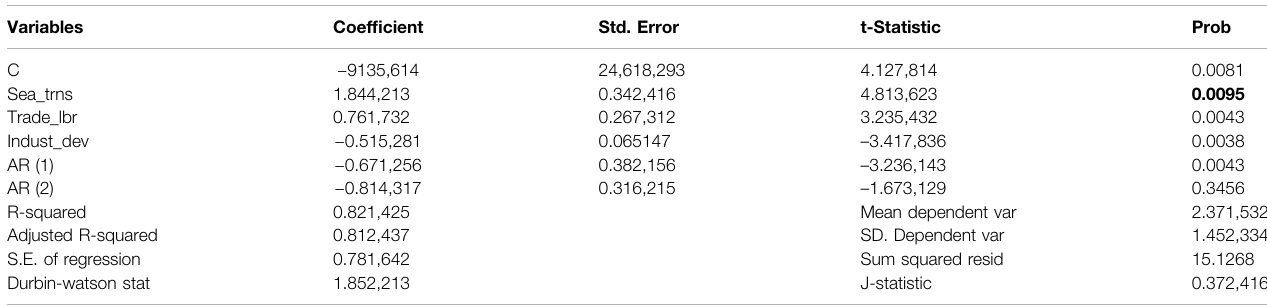
TABLE 8 | GMM (generalized method of moments) test results of China. Dependent variable: CO 2, applied analysis: GMM, sample size: 1960 – 2019, observations: 60 Estimation weighting matrix: TSLS two stage least squares Standard errors and covariance computed using estimation weighting, matrix: C D (GDP) D (Ext_debt) D